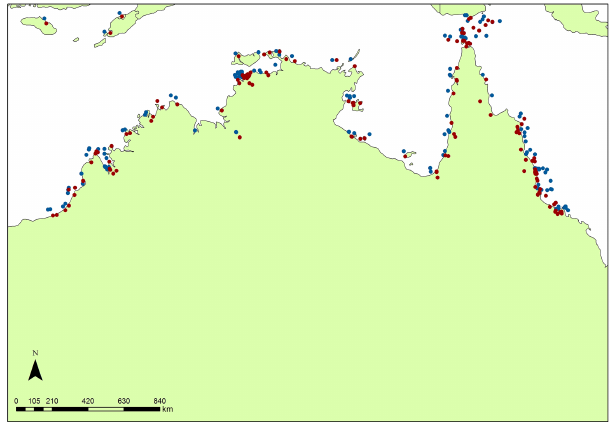
Figure 6. Map of the original station location situated in the ocean (blue dots) and the updated station location (red dots) for northern